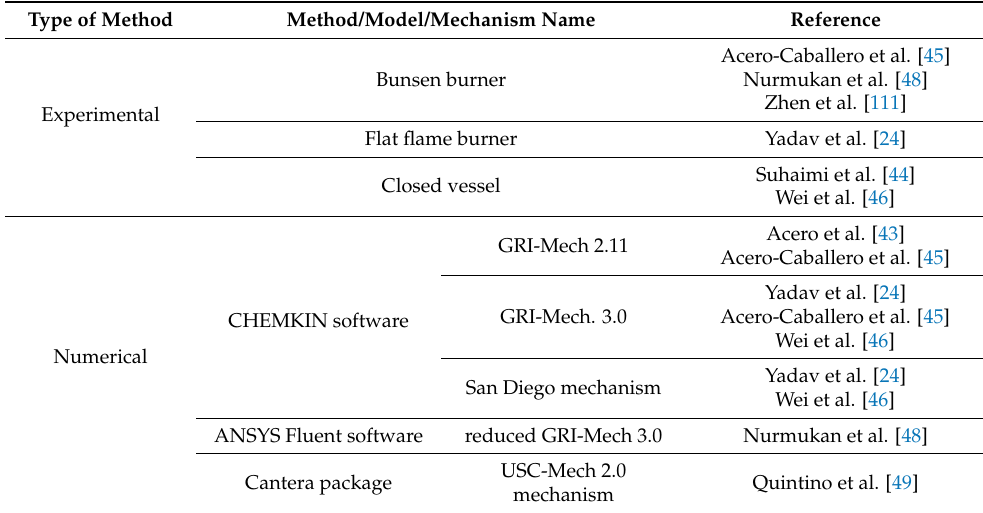
Table 5. Summary of experimental and numerical methods for obtaining the laminar burning velocity of biogas-H 2 -air mixtures presented in the present